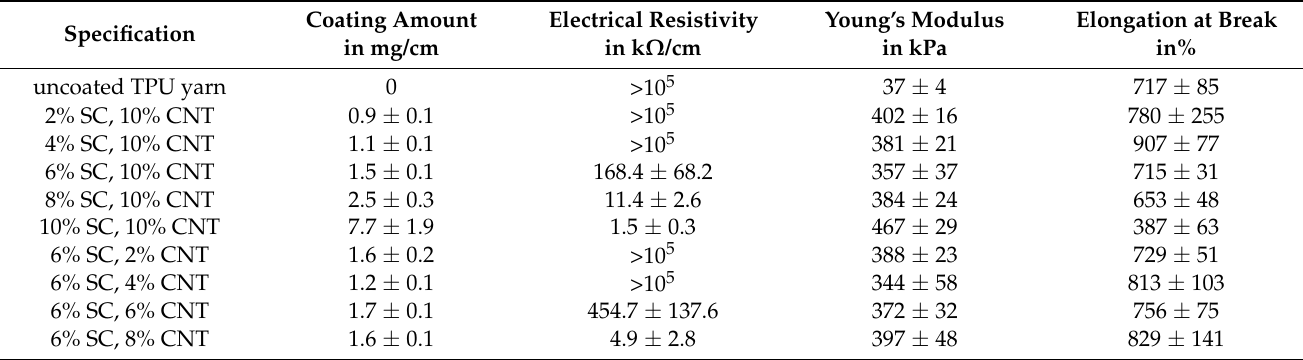
Table 1. Electrical and mechanical properties of multifilament yarns coated with different specifications of TPU–CNT– NMP solutions.